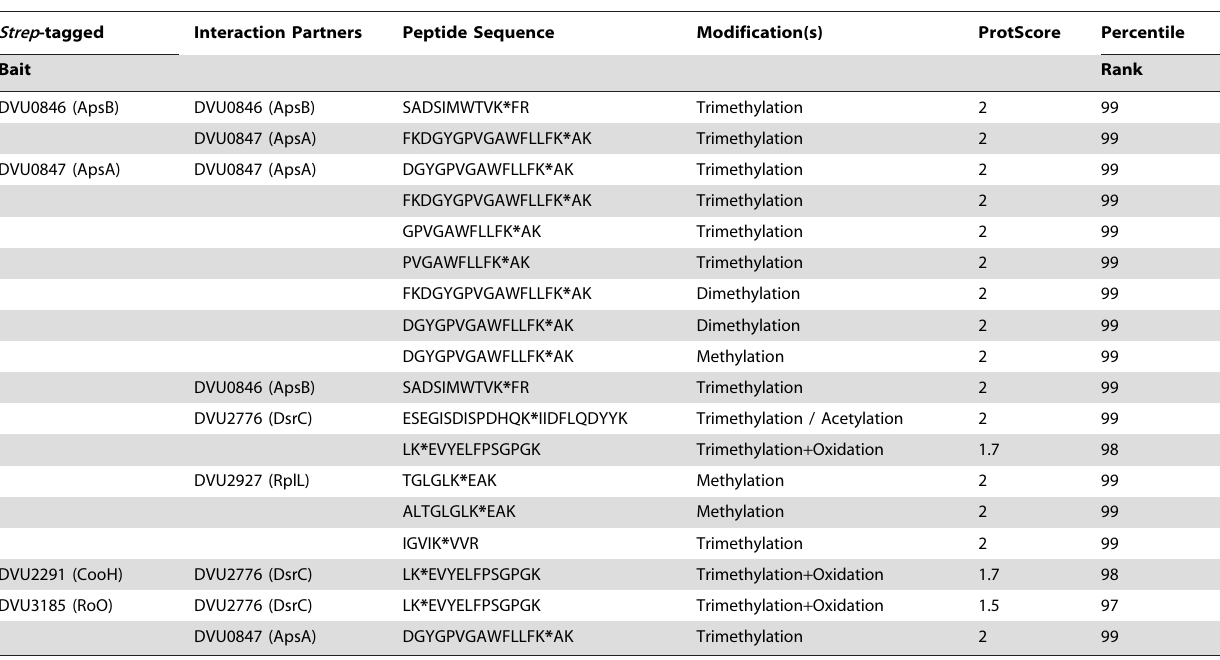
Table 1. Post-Translational Modifications Identified in this